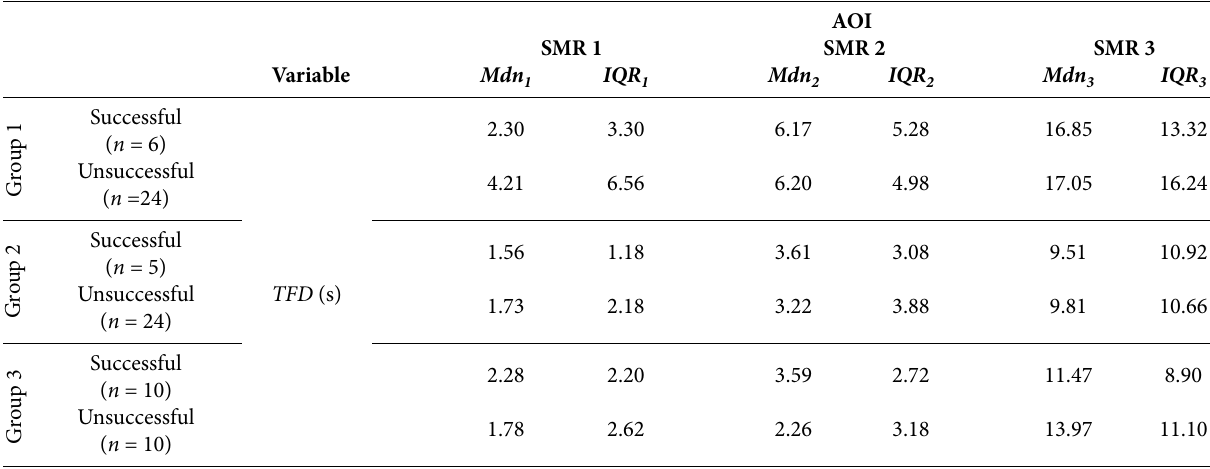
Table 4. Median (Mdn) and interquartile range (IQR) of interest for successful and unsuccessful students of 3 age groups in Task 2 (liquid state of water). The correct SMR is SMR